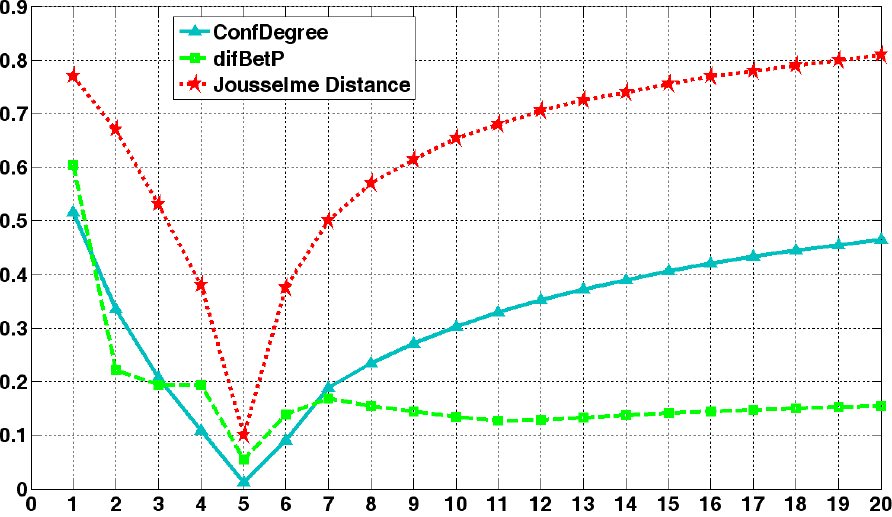
Figure 5. The curve lines of the conflict based on the results of the three